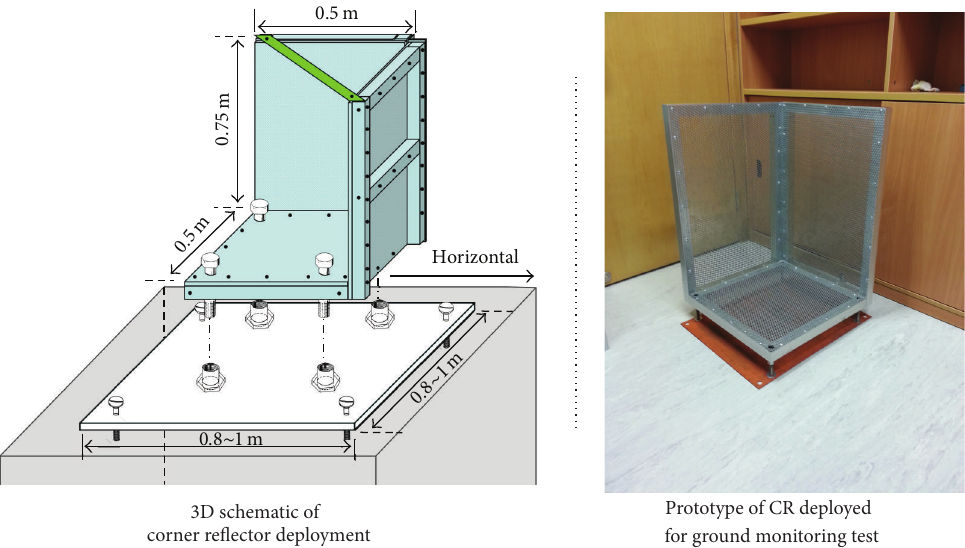
Figure 1: Schematic of corner reflector deployment.